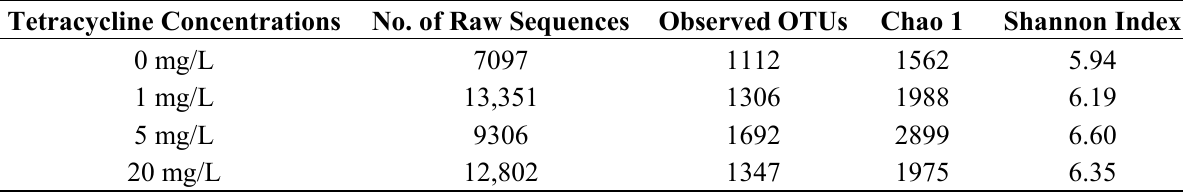
Table 1. Number of 16S rRNA gene sequences analyzed, observed OTUs, Chao 1 and Shannon index for each sample at similarity of 97%.